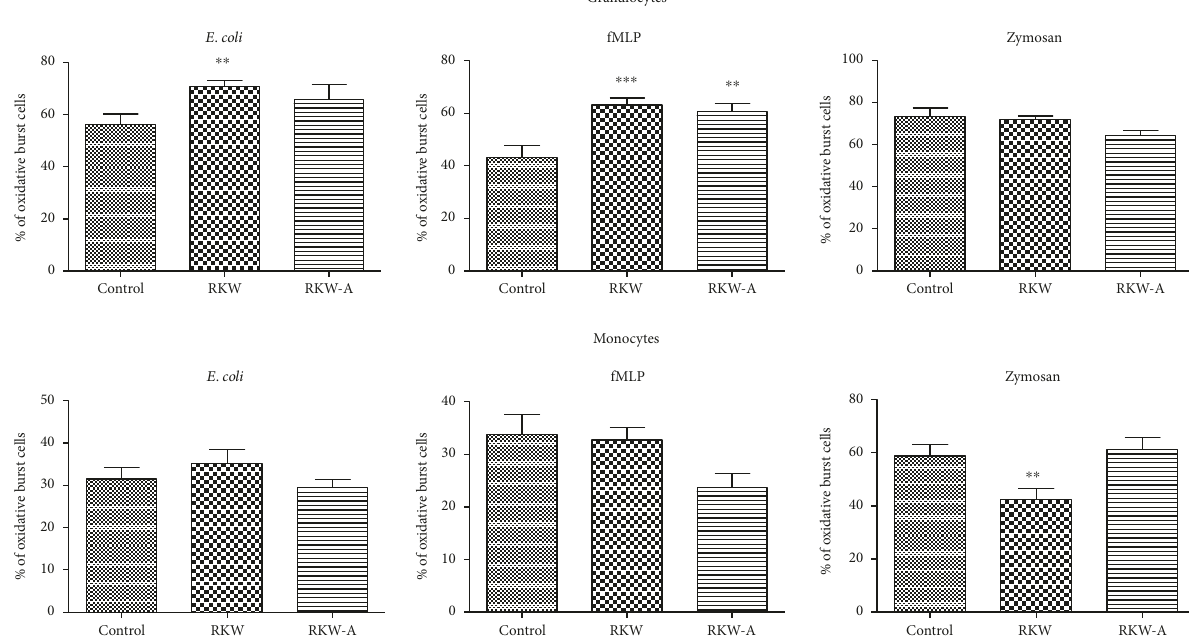
Figure 5: Oxidative burst. Analysis was performed in the o ff spring of mothers fed during pregnancy and lactation with water (RKW) or hydroalcoholic (RKW-A) extract of Rhodiola kirilowii . ∗∗ P < 0 01 ; ∗∗∗ P < 0 001